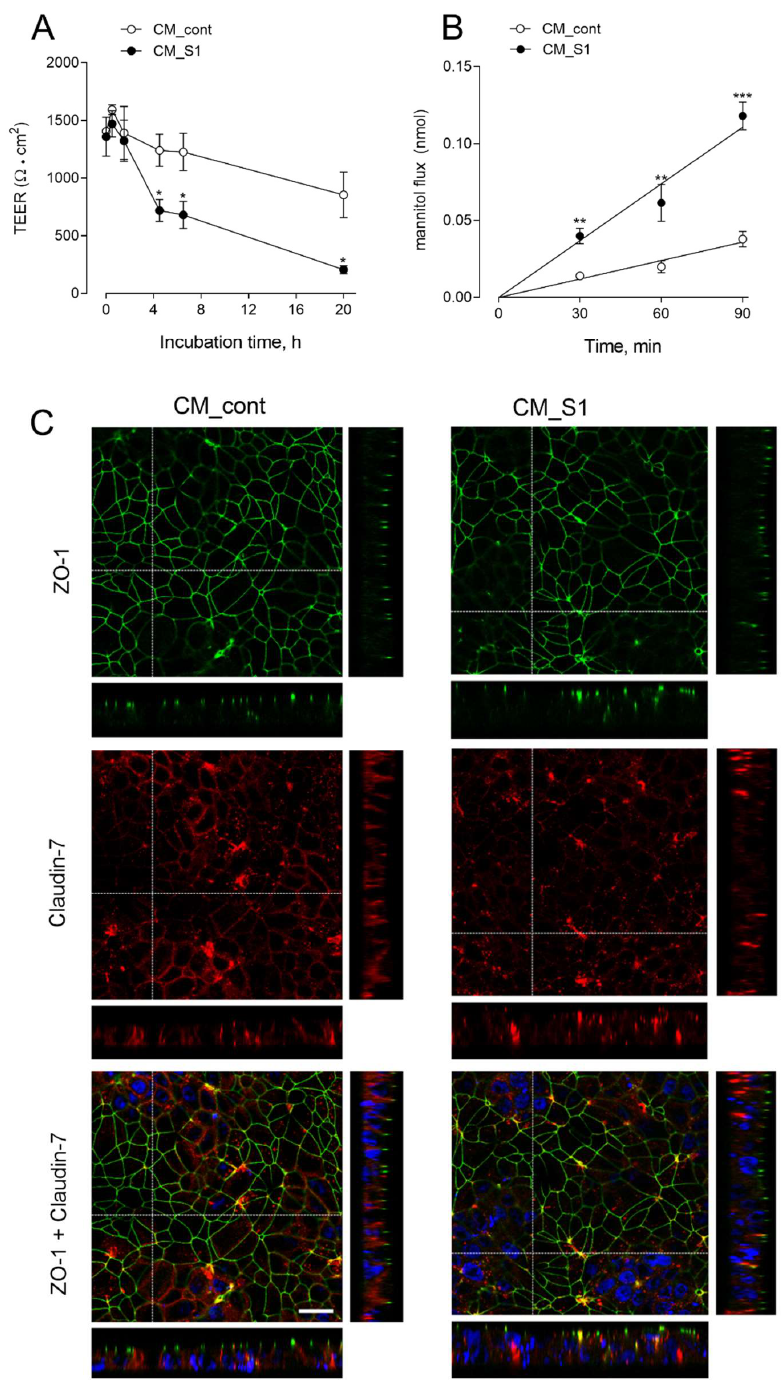
Figure 5. hAELVi, cultured under air–liquid interface (ALI) conditions for 20 d, were incubated with conditioned medium (CM) from untreated (CM_cont) or S1-treated (CM_S1) monocyte-derived macrophages (MDM). Transepithelial electrical resistance (TEER) values were measured at the indicated times (Panel A ) and mannitol fluxes were monitored after 24 h (Panel B ), as described in Methods. Data represent the mean ± SEM of three independent determinations. * p < 0.05, ** p < 0.01, *** p < 0.001 vs. CM_cont (Panel C ). After 24 h cells were fixed and immunostained for ZO-1 (green) and claudin-7 (red); for each condition, a single horizontal confocal section of a representative field is shown, with orthogonal projections. Bottom images show the merged signals of ZO-1, claudin-7 and Hoecst33342 (blue) employed for nuclear staining (see Methods). The experiment was performed twice with similar results. Bar = 20 µ